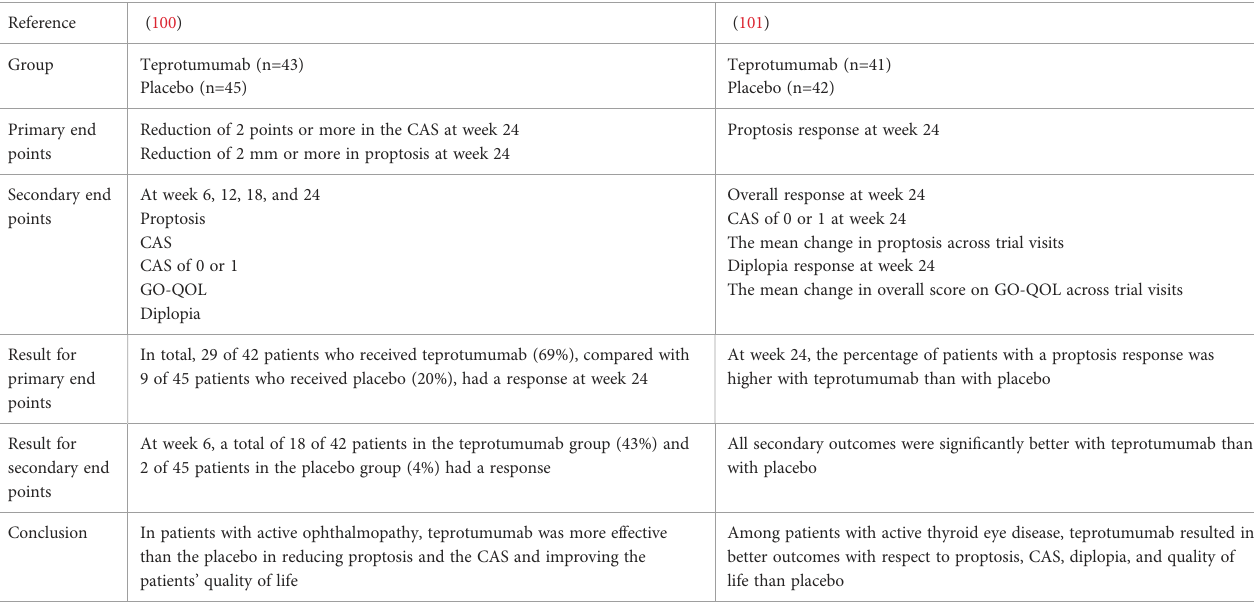
TABLE 2 Summary of two teprotumumab clinical trials for